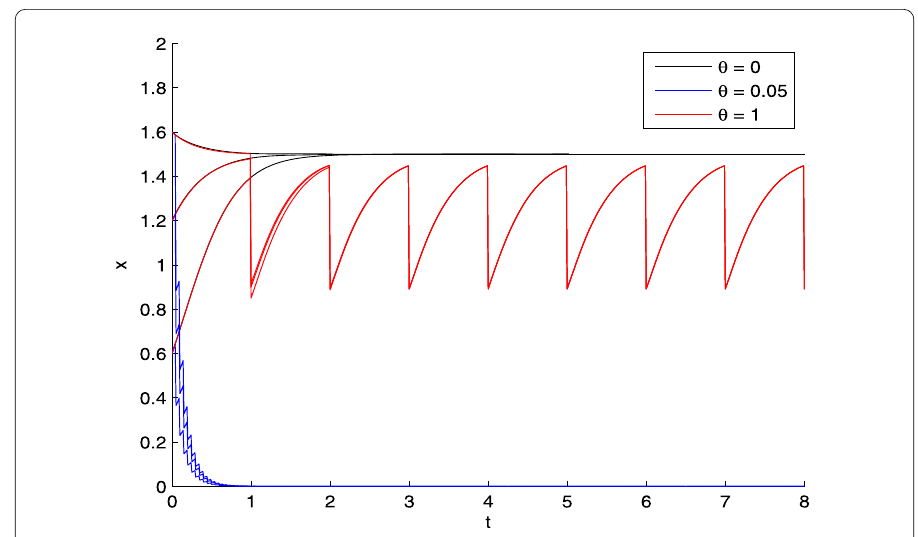
Figure 5 Dynamic behaviors of the species x ( t ) in system (1.4) with the initial conditions x (0) = 0.6, x (0) = 1.2, x (0) = 1.8,